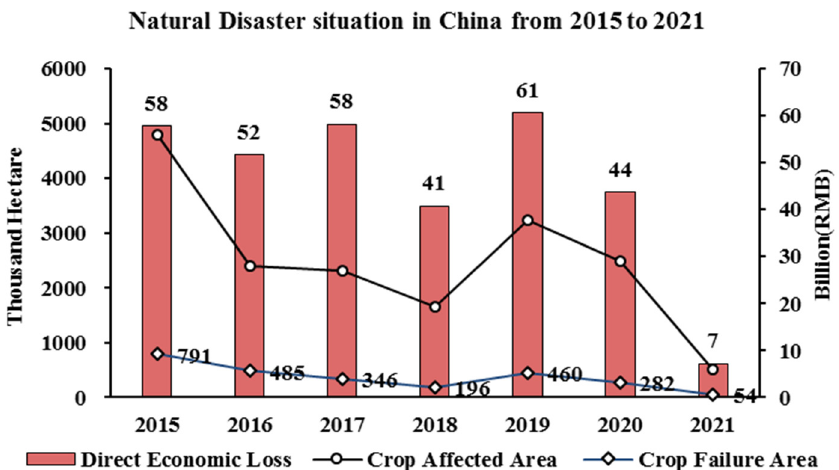
Figure 2. Disaster situation of natural disasters in China from 2015 to 2021. From the view of the average damage caused by natural disasters in each county from 2015–2021, as a whole, most counties in Northeast and Central China and some coun- ties in Southwest, North, and Northwest China were more severely affected. Specifically, 142 counties in North China were affected for more than 1000 hectares, with the top three counties being Horqinzuoyihou Banner, Jalaid Banner, and Horqinyouyihou Banner. A total of 110 counties in Northeast China had 1000 hectares or more affected and rounding out the top three counties are Yilan County, Shuangcheng District, and Dunhua City.